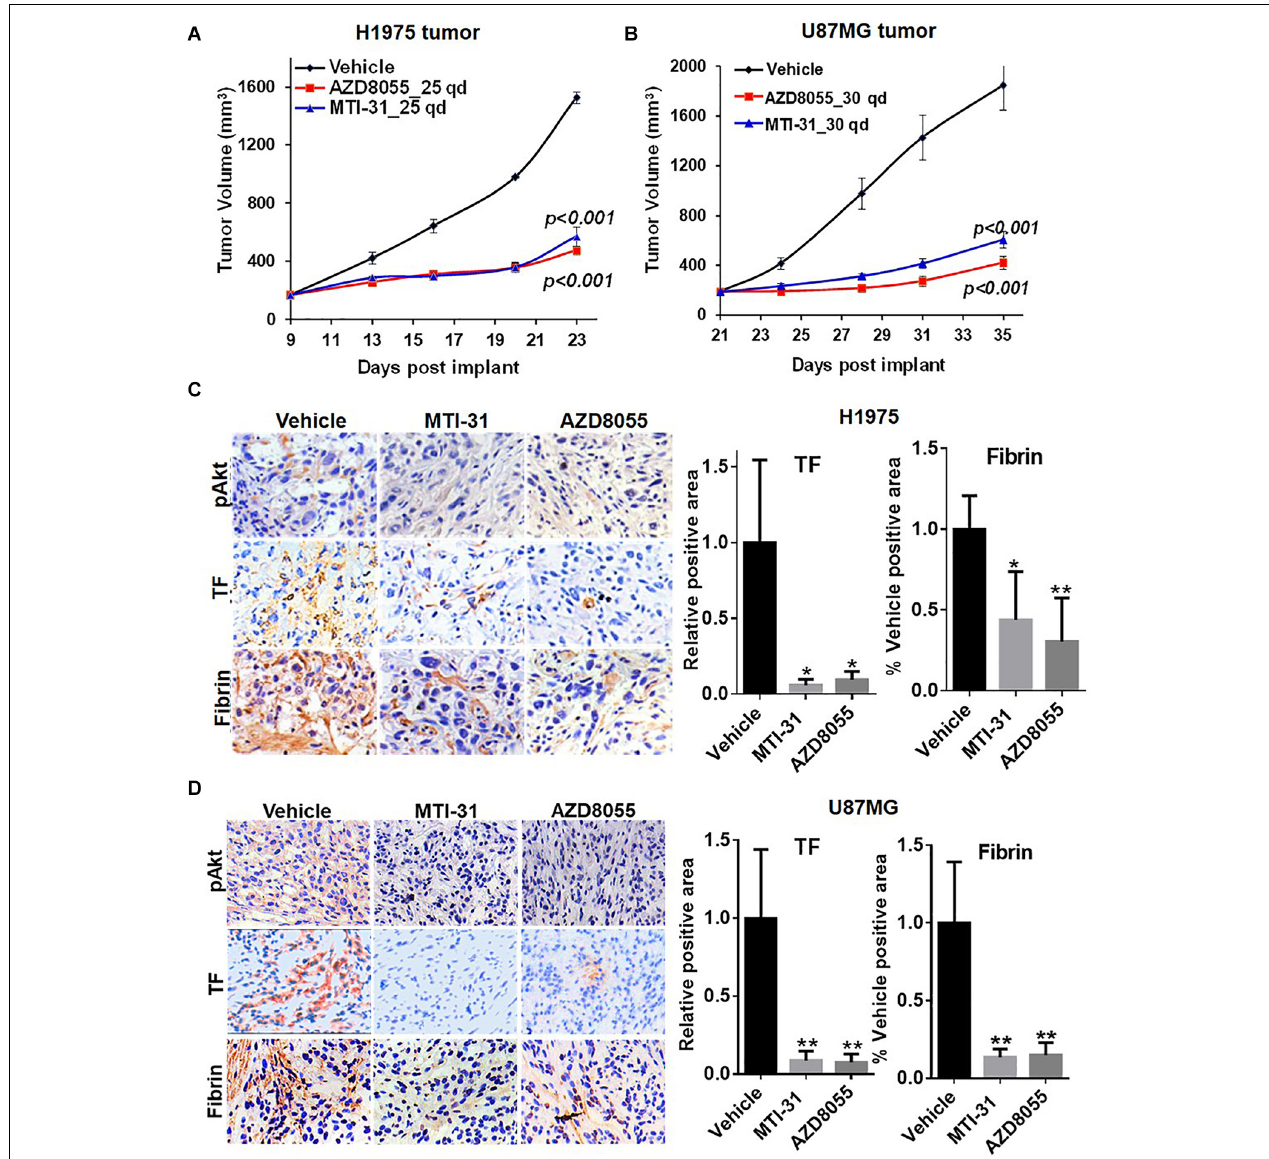
FIGURE 4 | Downregulation of TF expression and activity in EGFR-mut tumors in vivo . (A,B) Studies of H1975 and U87MG tumor growth in nude mice and mTOR inhibitor treatment with MTI-31 or AZD8055 were performed as described in section “Materials and Methods.” (C,D) On final day of tumor growth studies, H1975 tumors (C) and U87MG tumors (D) were dissected and analyzed by IHC and/or IF as described in section “Materials and Methods.” Tumor slides were probed with anti-pAkt, anti-TF and anti-fibrin (left panels) quantified (right panels). * P < 0.05, ** P <